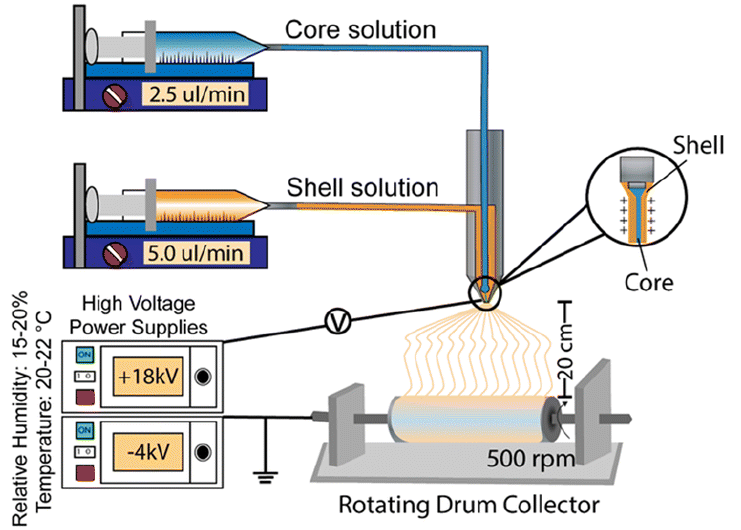
Figure 10. Coaxial electrospinning. Adapted from [204], originally published under a CC-BY 4.0 license. 4.0